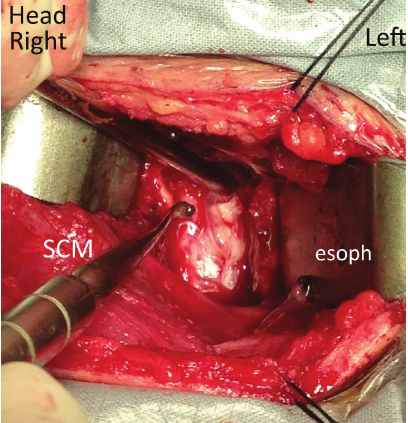
Figure 4: Intraoperative photograph before removal of the her- niated disc fragment. Surgical approach was from the right side. There is a dural tear with a distinct preserved arachnoid layer. The disc fragment is near the tip of the metal suction. SCM = sternocleidomastoid muscle. Esoph = trachea and esophagus deep to the